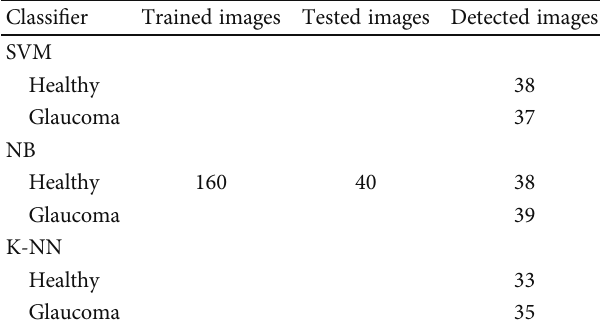
Table 1: Classi fi cation results.